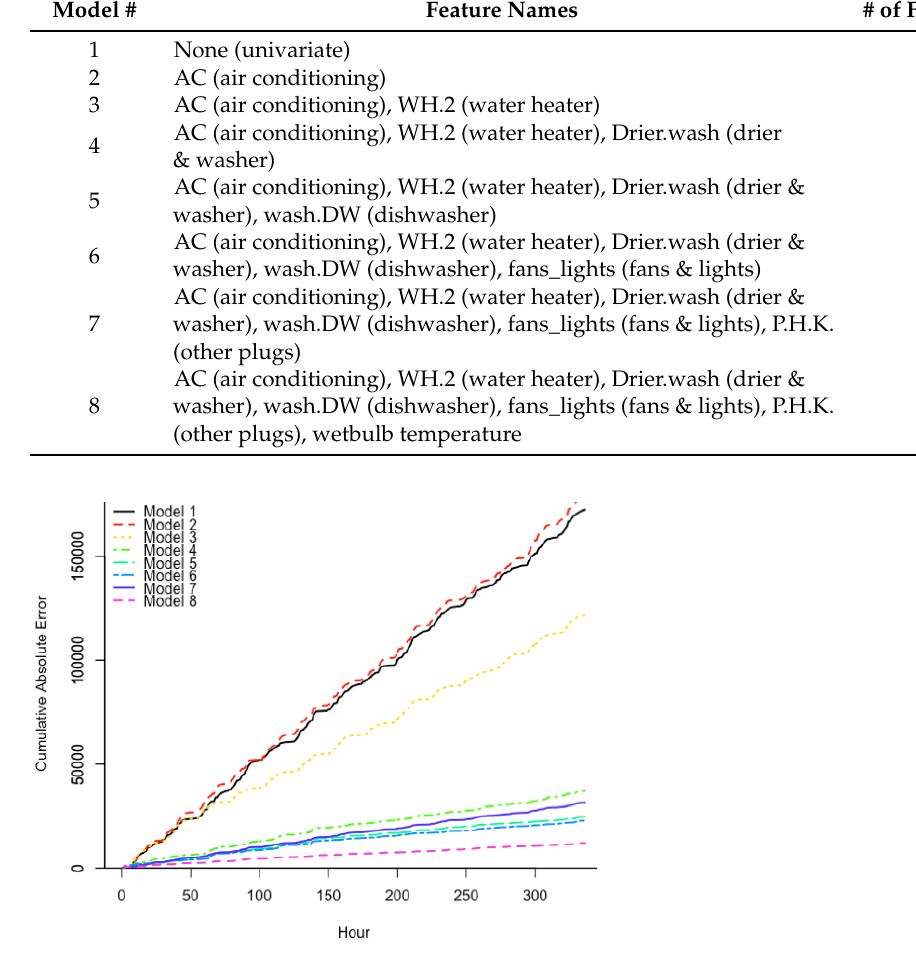
Figure 4. The cumulative absolute error over the training period for each of the eight models